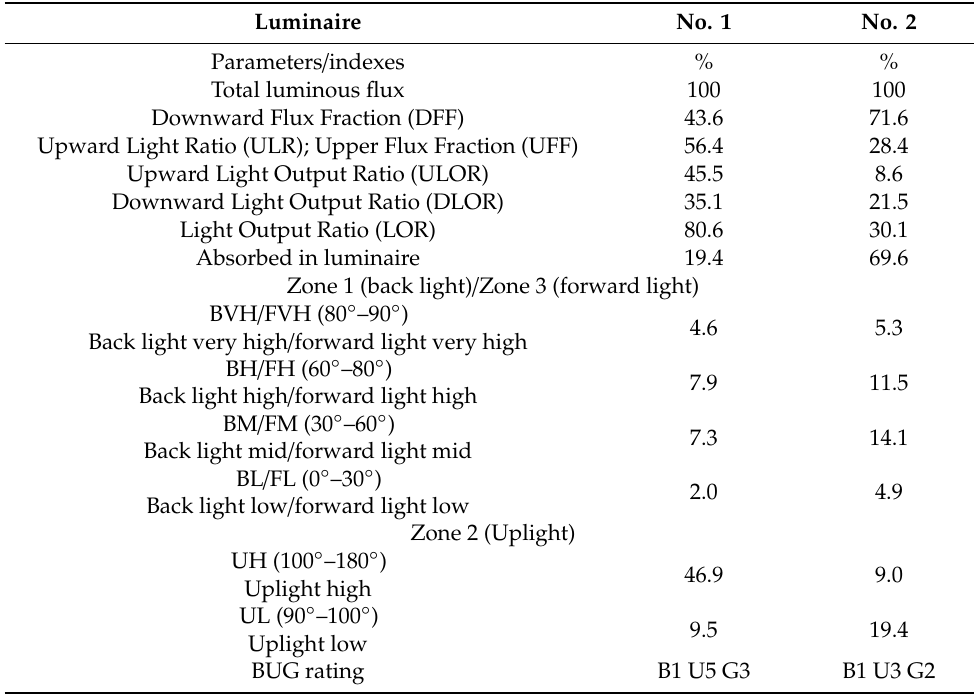
Table 1. Zonal lumen summary for opal-sphere-type